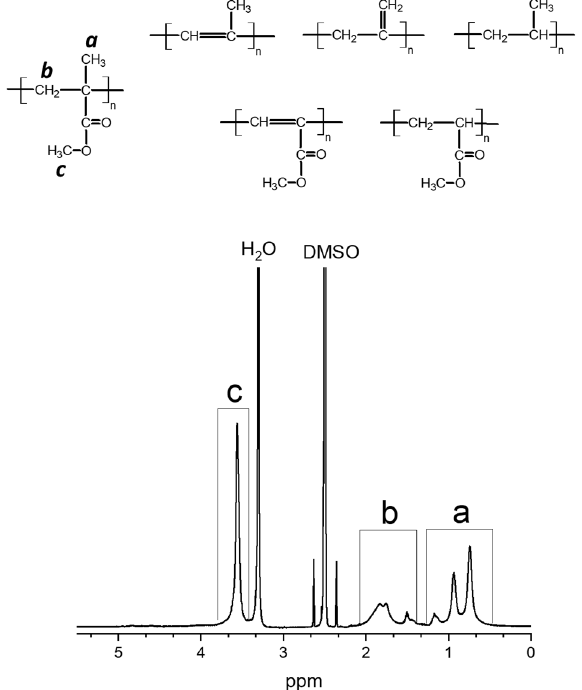
Figure 8. 1 H-NMR spectra of irradiated PMMA, with the possible repeating unit structures (top). Despite the results obtained by FT-IR, MALDI-TOF and 1 H-NMR appearing to not be in accordance, the partial solubility of irradiated PMMA must be considered. Indeed, FT-IR analyses, performed on the entire thin film having linear, branched and cross-linked chains, provide an overview of all the functional groups and transformations incurred by